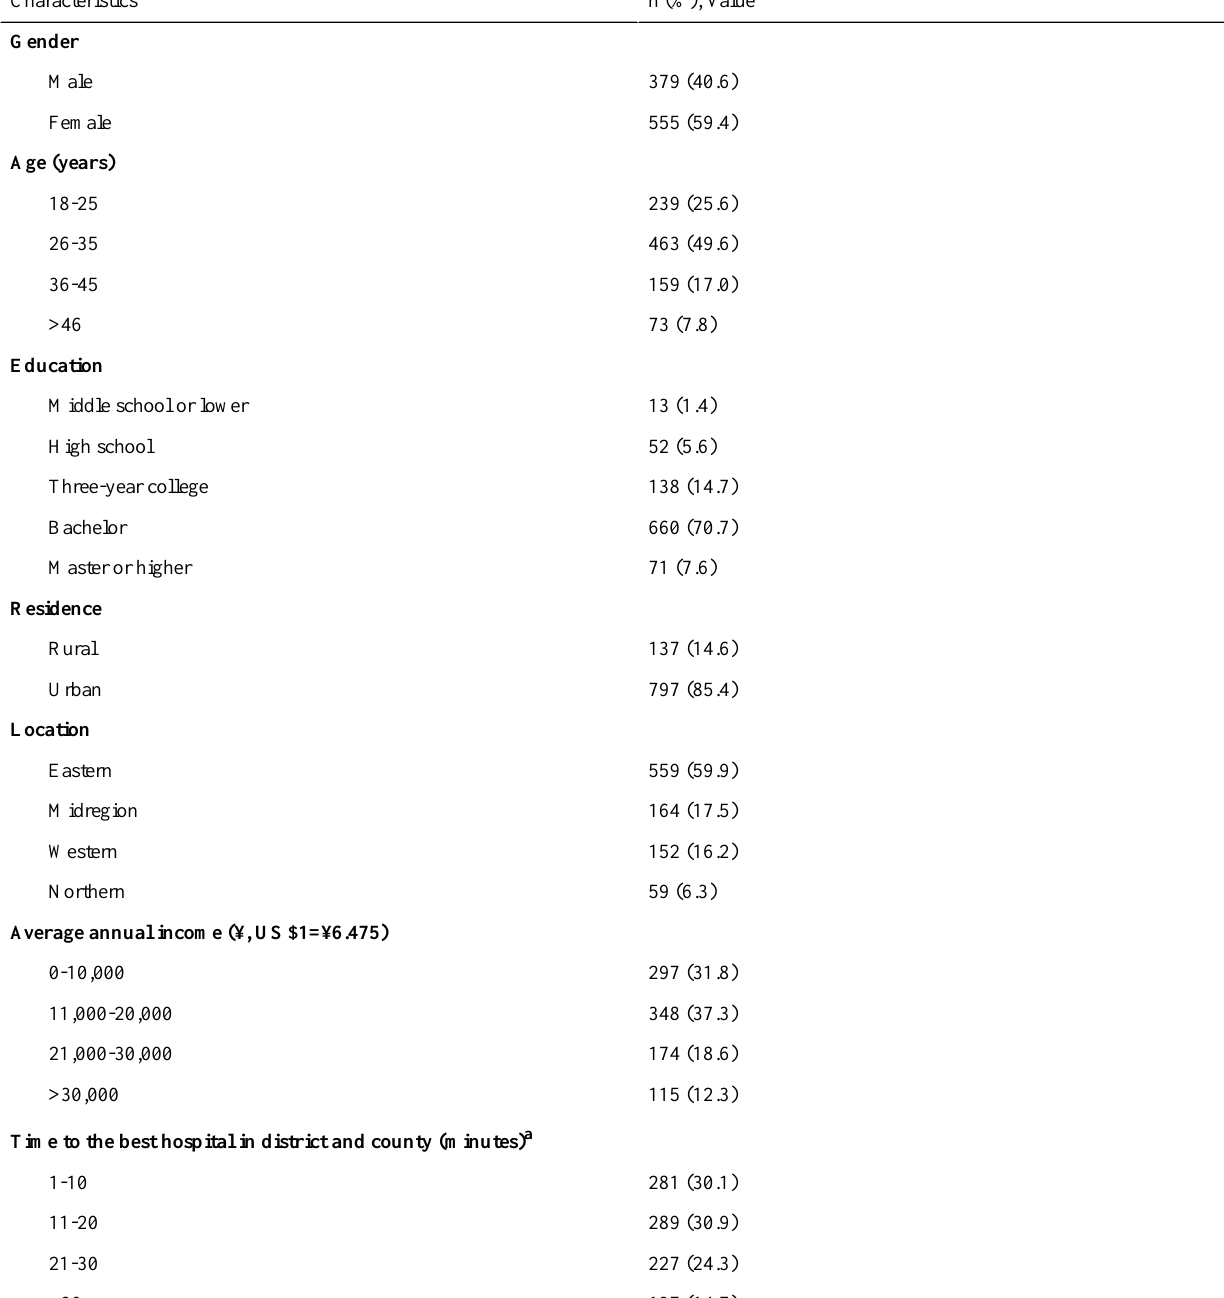
Table 2. Geographical characteristics of the respondents